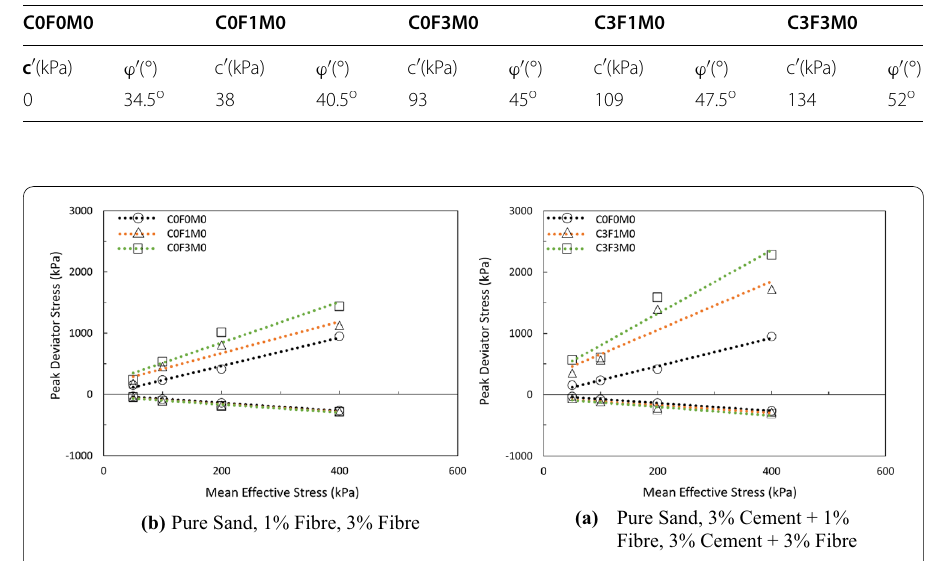
Table. 4 Mohr-Coulomb strength parameters, c ′ p and ϕ ′ p , for unreinforced, fibre reinforced, and fibre reinforced cemented Toyoura sand from CID compression tests At peak